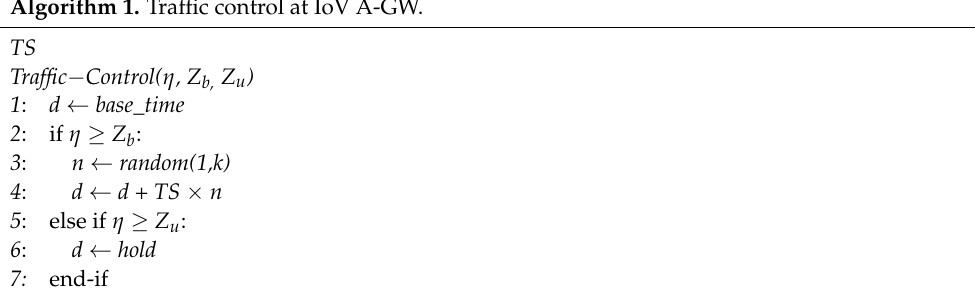
Algorithm 1. Traffic control at IoV